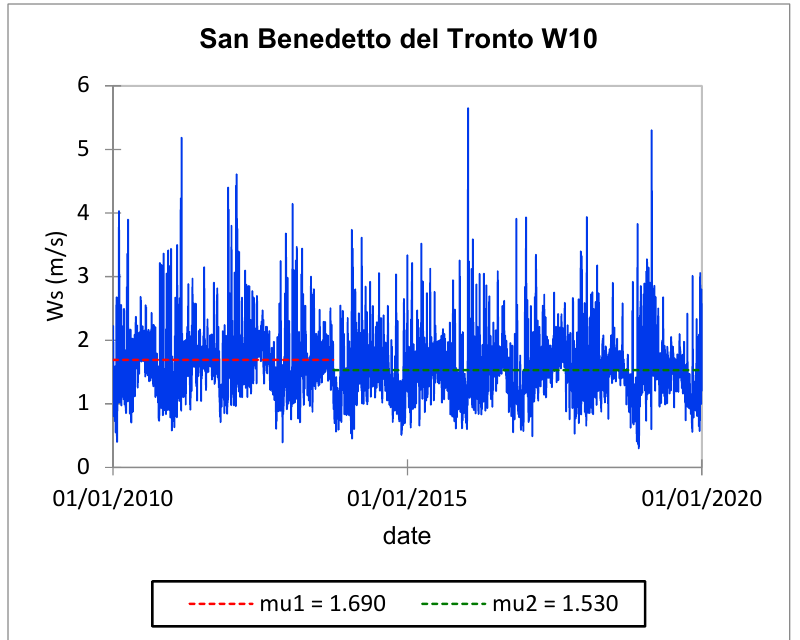
Figure 2. Pettitt’s test on Ws (daily average wind speed) data from 2010 to 2020 for the weather station of San Benedetto del Tronto (W10); mu1 is the average of the period before the breakpoint; mu2 is the average of the period after the breakpoint.